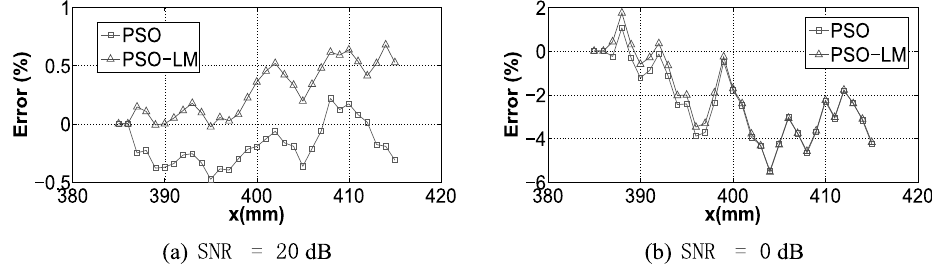
Fig. 17. Relative error in the identi fi cation for a low (0 dB) and moderate (20 dB) levels of SNR, Case 2 (Part 1).